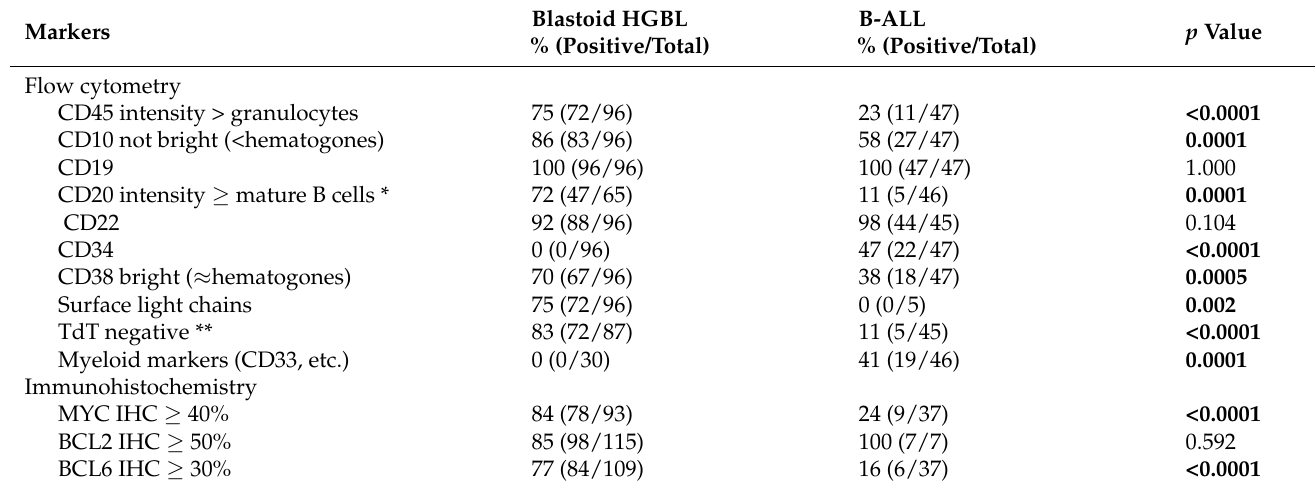
Table 1. Comparison of immunophenotyping between blastoid HGBL and B-ALL.